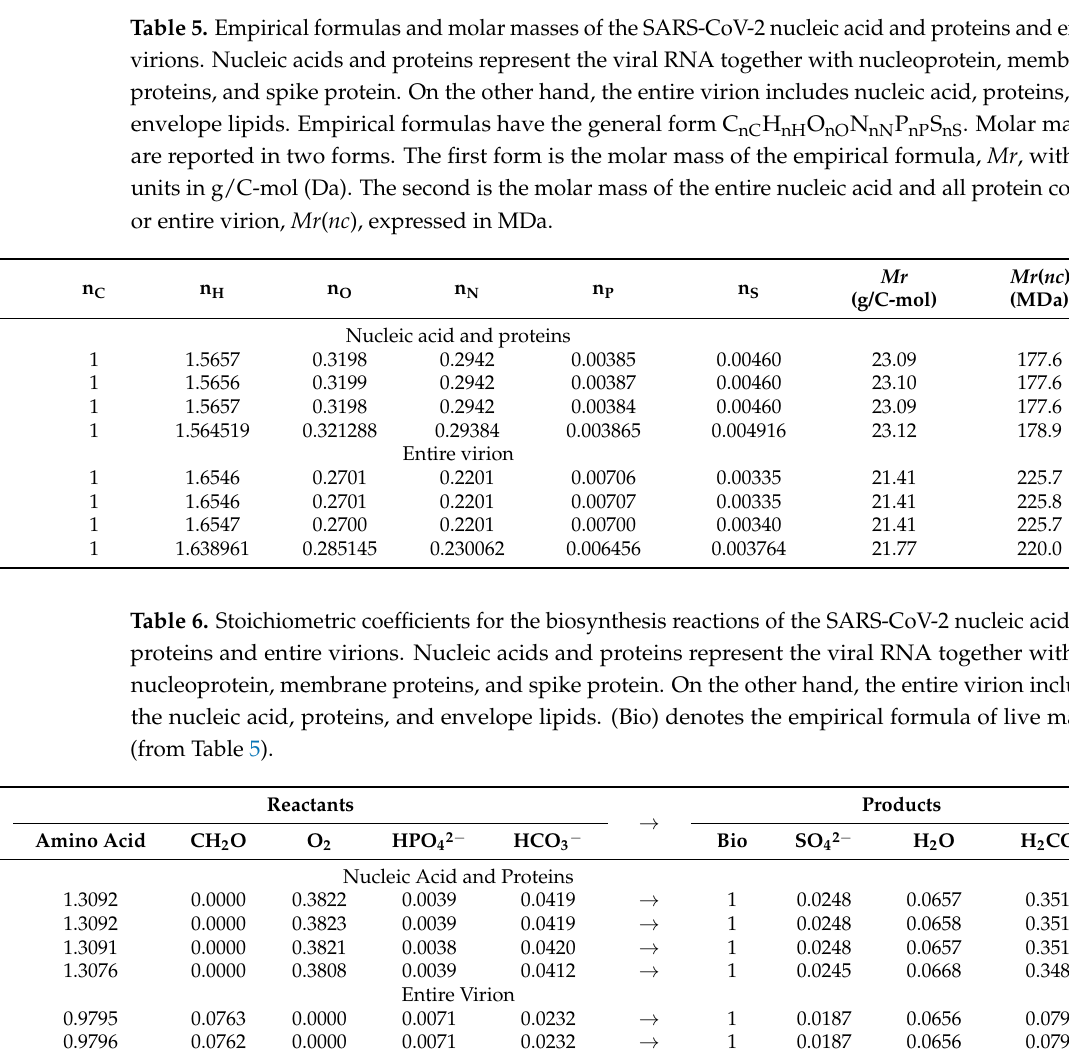
Table 4. Standard thermodynamic properties of biosynthesis of the Omicron BA.2.75 subvariant. The table gives data on the standard enthalpy of biosynthesis, ∆ bs H 0 , standard entropy of biosynthesis, ∆ 0 , and standard Gibbs energy of biosynthesis, ∆ bs S